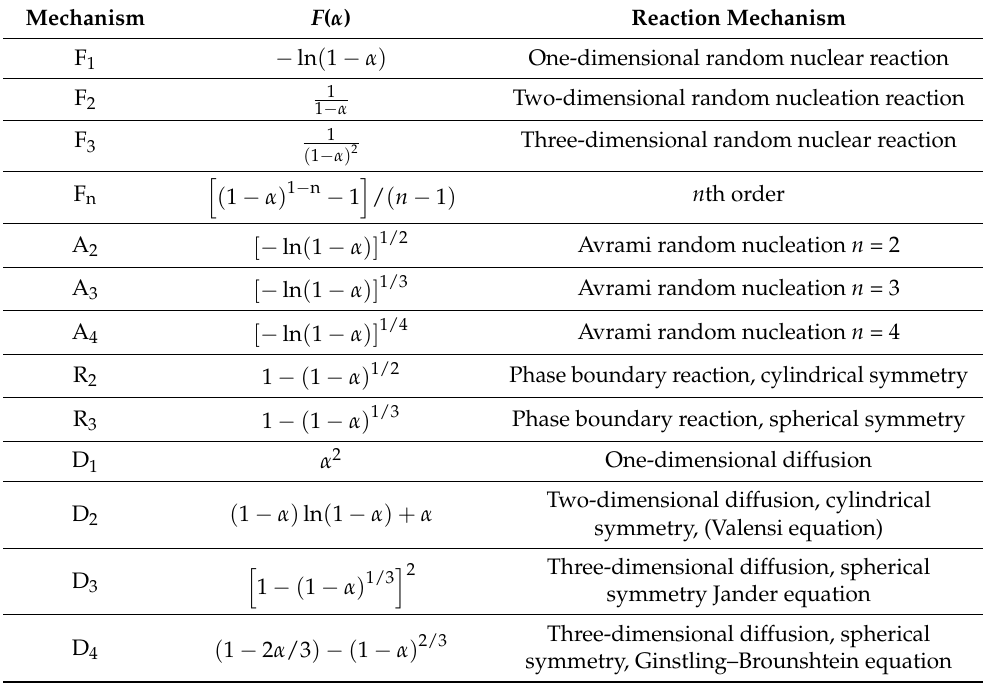
Table 3. Thirteen kinds of commonly used pyrolysis kinetics models.